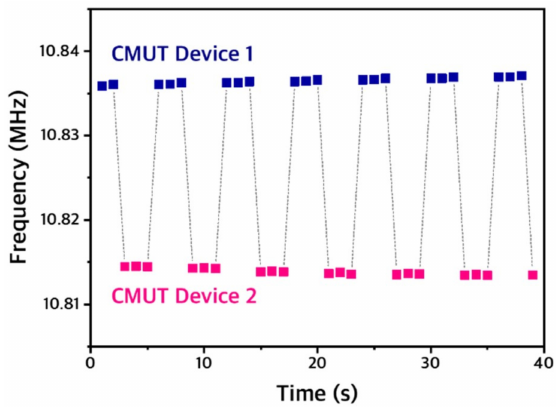
Figure 8. Transient plot of the output frequency of the single oscillator interfaced with two CMUT sensors through a relay, which switched between two sensors every 3